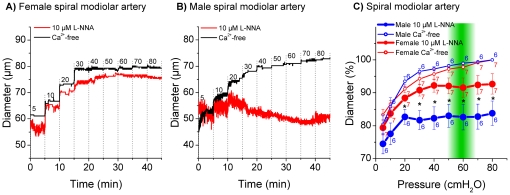
Pressure dependent diameter of female and male spiral modiolar artery.Original trace of female (A) and male (B) spiral modiolar artery in 10 µM L-NNA and Ca2+-free solution. Diameter in % in 10 µM L-NNA and Ca2+-free solution (C), % values were normalized to maximal diameter measured in Ca2+-free at 80 cmH2O. 100% = 81.2 µm±4.5 in Ca2+-free at 90 cmH2O in female animals and 77.7 µm±2.9 in Ca2+-free at 90 cmH2O in male animals. “*” indicates statistical significance (p<0.05) by ANOVA (2-factor repeated-measures).